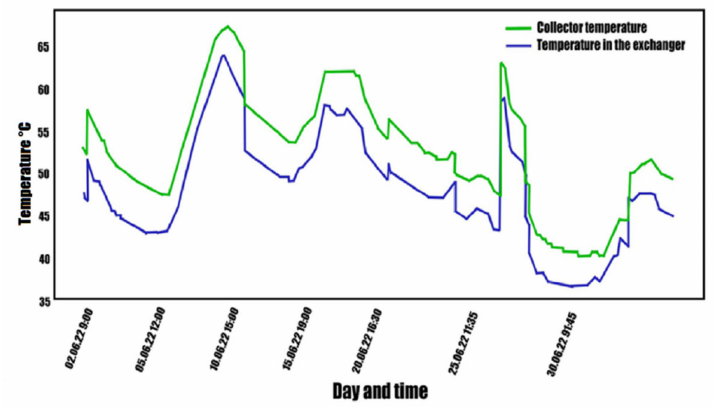
Figure 10. Temperature dependence on day and